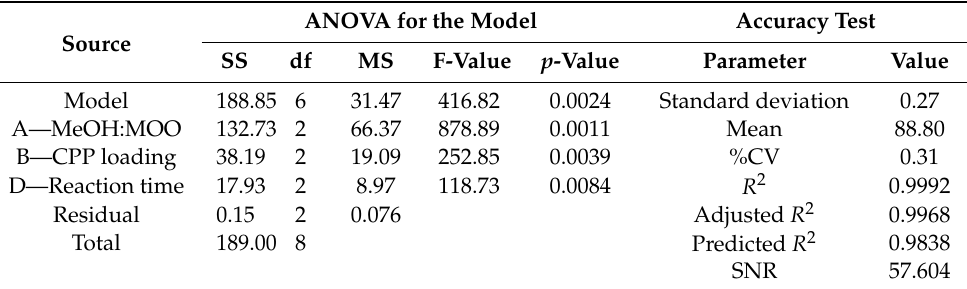
Table 3. Statistics for the regression model for MOOME production